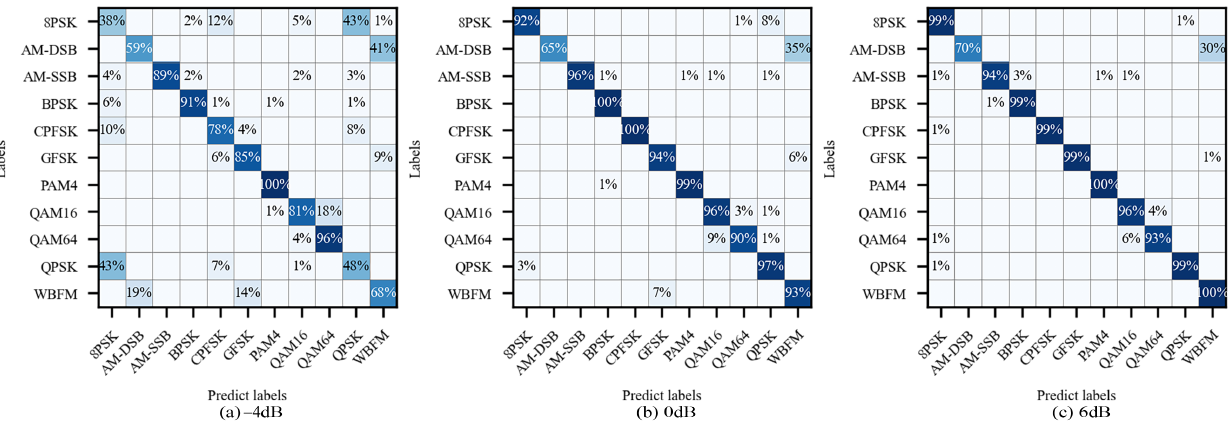
Figure 8. Confusion matrix of the hybrid parallel network for different Signal to Noise Ratios (SNRs). ( a ) The confusion matrix of the hybrid parallel network for an SNR of − 4 dB. ( b ) The confusion matrix of the hybrid parallel network for an SNR of 0 dB. ( c ) The confusion matrix of the hybrid parallel network for an SNR of 6 dB. Figure 9 displayed the distribution of extracted features at − 4 dB, 0 dB and 6 dB. The features are extracted at the penultimate layer of our proposed method, where the last layer is the AM-softmax layer. The features from the penultimate layer are 128